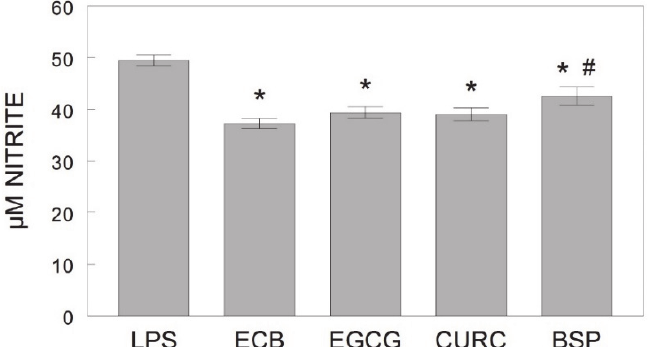
Figure 3. Production of extracellular NO, as measured by µM nitrite, in HAPI rat microglial cells pre-treated with ECB or its component phytochemicals (EGCG, CURC, BSP) and stimulated 18 h overnight with LPS (100 ng/mL). Data are represented as mean ± SEM (µM nitrite) and quantified using Greiss reagent. Each phytochemical pre-treatment was compared against LPS alone and individual components were compared to ECB. Comparative post-hoc analyses were made by Fisher’s LSD post-hoc test with significance at (*) p < 0.05 versus LPS or (#) p < 0.05 versus ECB. LPS = lipopolysaccharide only; ECB = combination compound; EGCG = epigallocatechin gallate; CURC = curcumin; BSP = broccoli sprouts.